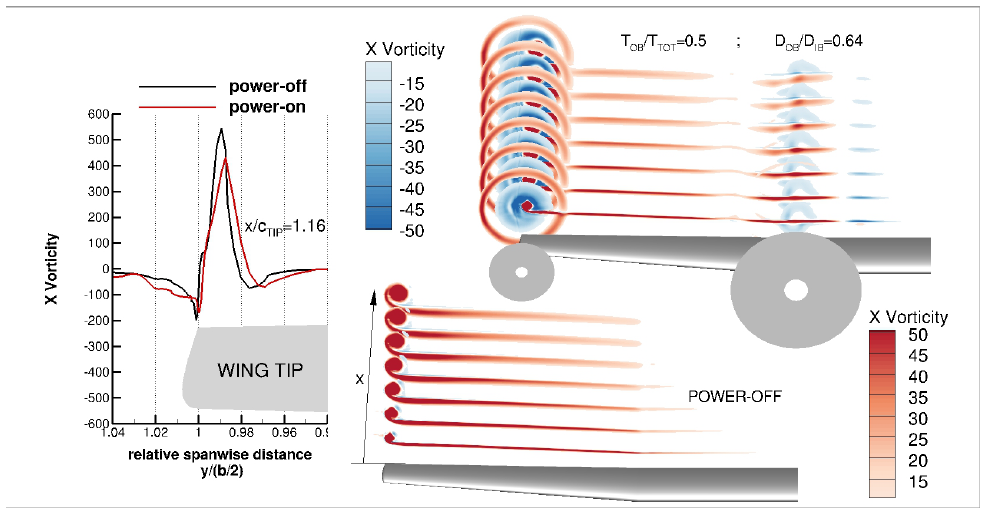
Figure 19. Effect of OB propeller swirl on wing tip vortex in cruise conditions ( M = 0.480; Re = 16.6 × 10 6 ) at global AoA = 0 ◦ .